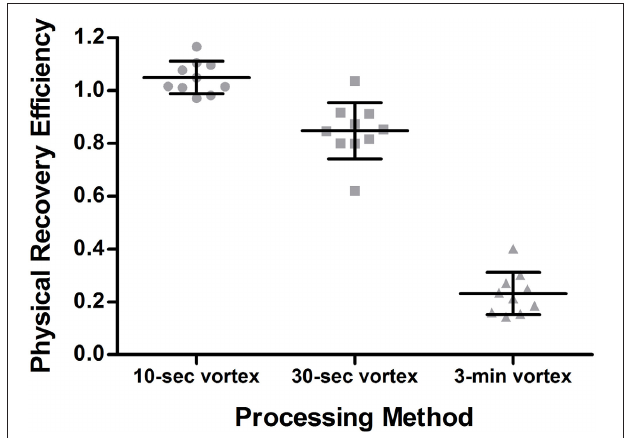
FIGURE 1 | Physical recovery efficiency of 1 µ m fluorescent melamine beads from 25mm gelatin filters. The physical recovery efficiency of fluorescent beads from gelatin filters following 3min of vortexing in room temperature water was significantly less than the other three processing methods ( P < 0 . 0001); lines represent the mean, and ± one standard deviation; n = 10 for each processing method.